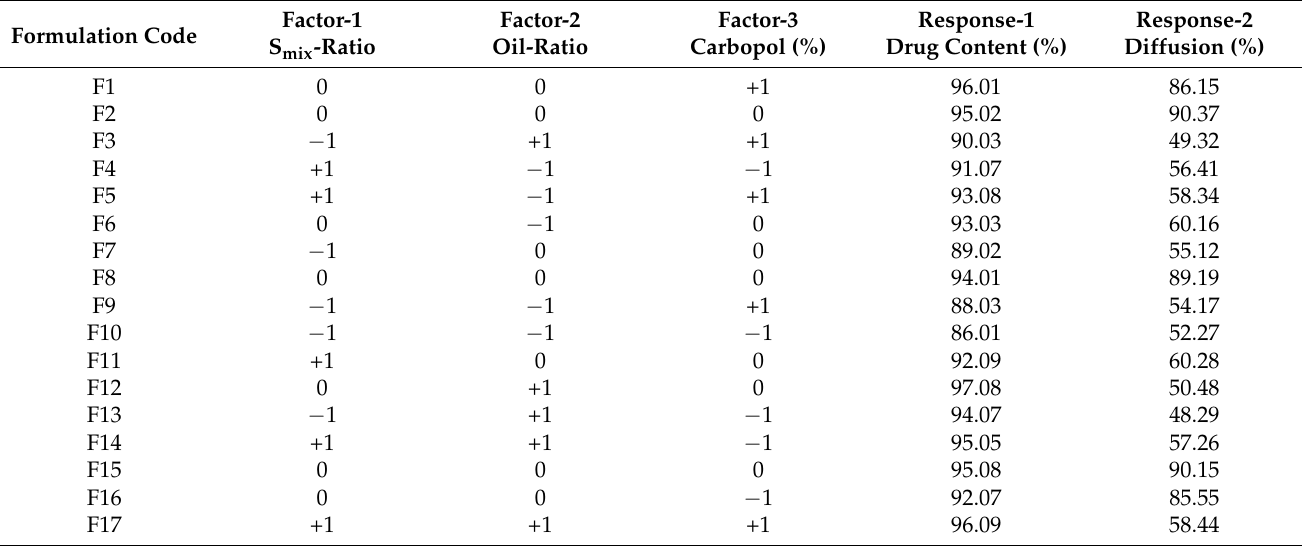
Table 5. Observed responses for transemulgels obtained from